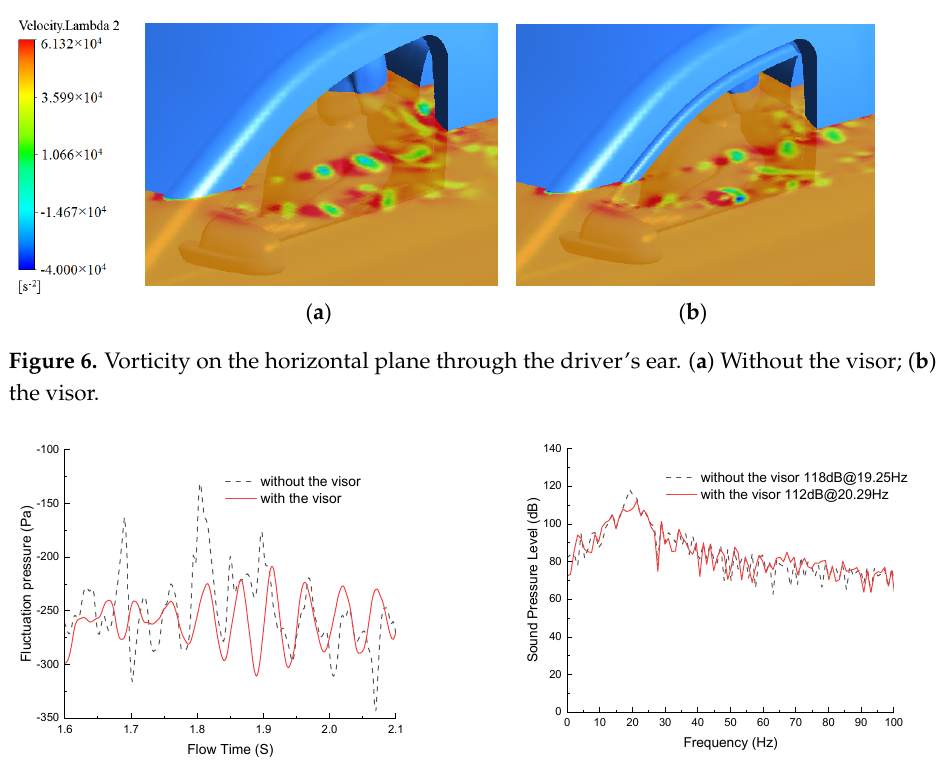
Figure 7. Fluctuation pressure and sound pressure level at the driver’s left ear with the fully opened left front window. ( a ) Fluctuation pressure; ( b ) Sound pressure level.